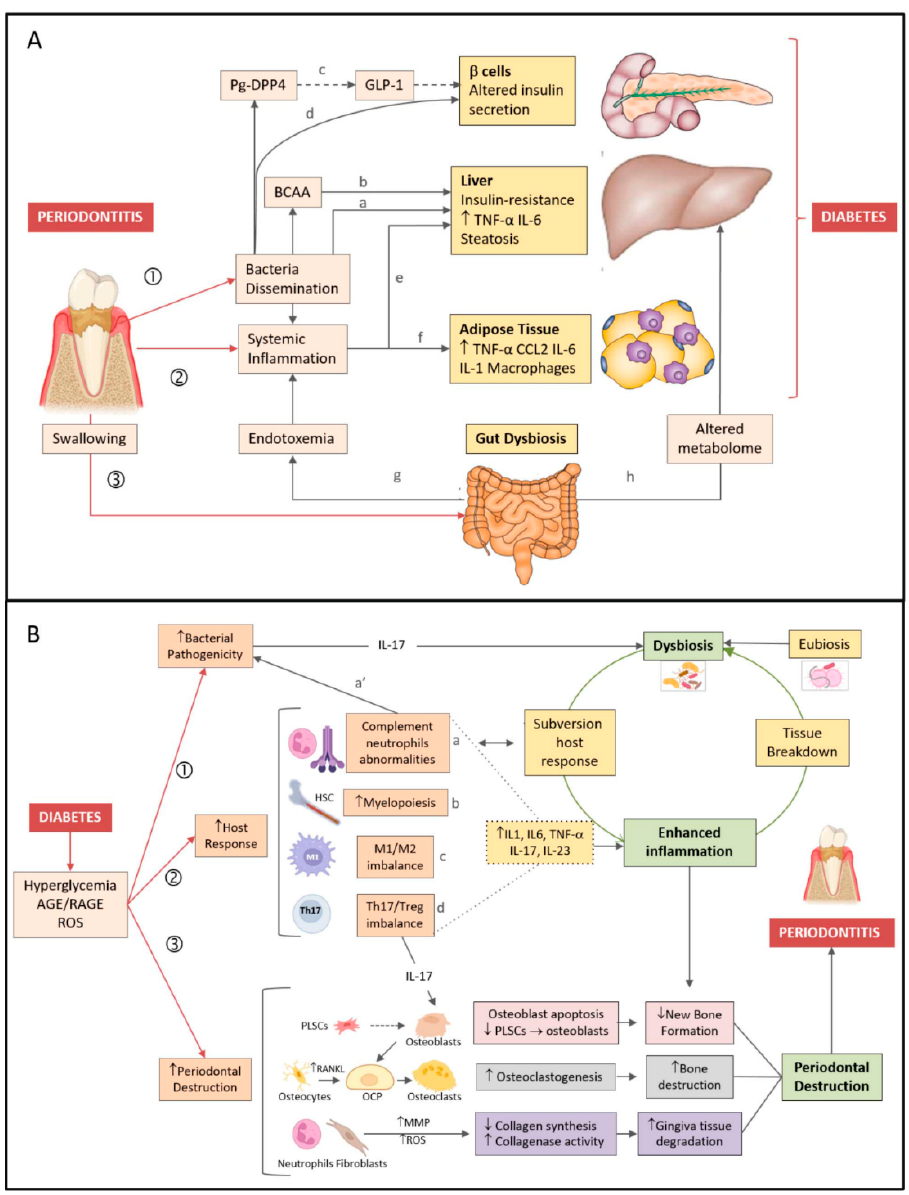
Figure 1. Bidirectional relationship between periodontitis and diabetes. ( A ) Periodontitis diabetes direction. Periodontitis favors development/worsening of type 2 diabetes by three major mechanisms: (1) Dissemination of periodontal bacteria/bacterial products into the bloodstream. Bacteria/bacterial products can induce insulin resistance (a) by inhibiting hepatic glycogen synthesis, increasing hepatic gluconeogenesis, and (b) blocking the insulin receptor substrate via production of branched-chain amino acids (BCAA). (c) Dipeptidyl peptidase-4 (DPP4) produced by P. gingivalis (Pg-DPP4) can reduce glucose-induced insulin production by enhancing glucagon-like peptide 1 (GLP-1) degradation (d) P. gingivalis may alter insulin production by inducing β cell dedifferentia- tion. (2) Induction/magnification of systemic inflammation, favoring both (e) hepatic and (f) adipose tissue insulin resistance. (3) Gut dysbiosis induced by swallowed periodontal bacteria, favoring